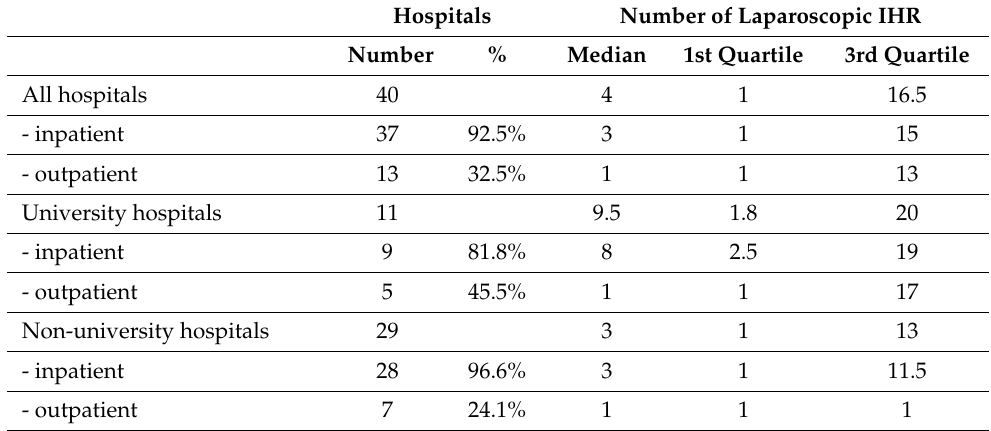
Table 4. Numbers of procedures of laparoscopic inguinal hernia repair (IHR) per pediatric surgical unit documented in the quality